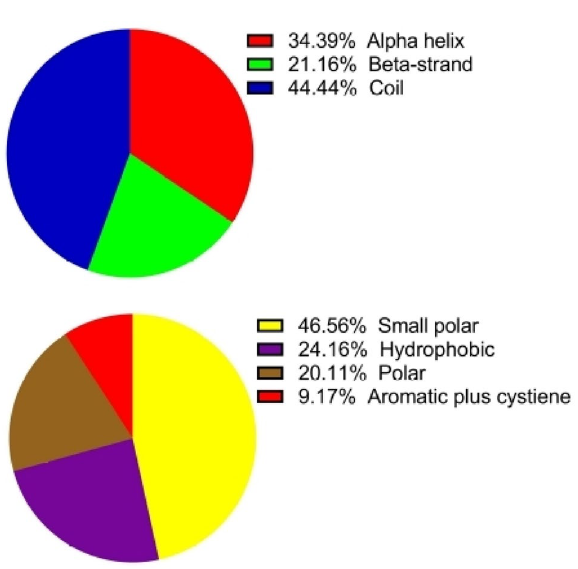
Figure 3. Graphical representation of the secondary structure of the subunit multi-epitopes vaccine construct predicted by the PSIPRED